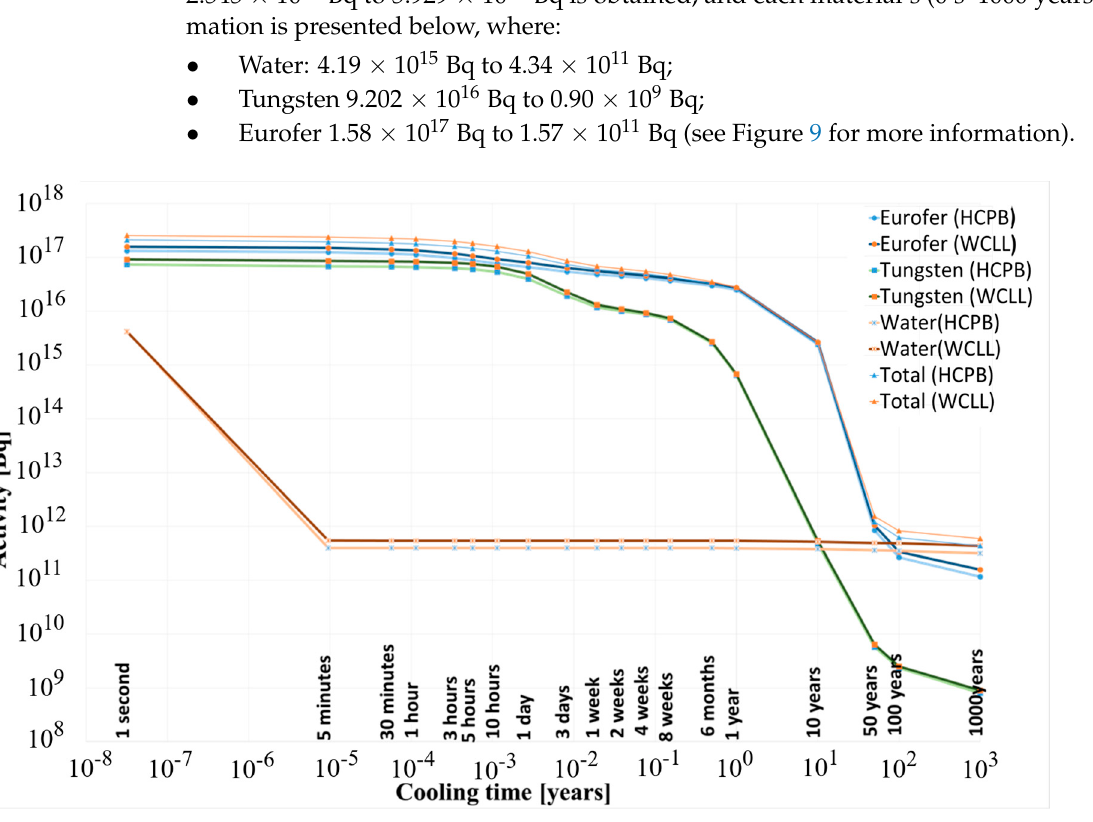
Figure 10. MCNP model of the divertor cassette [43].